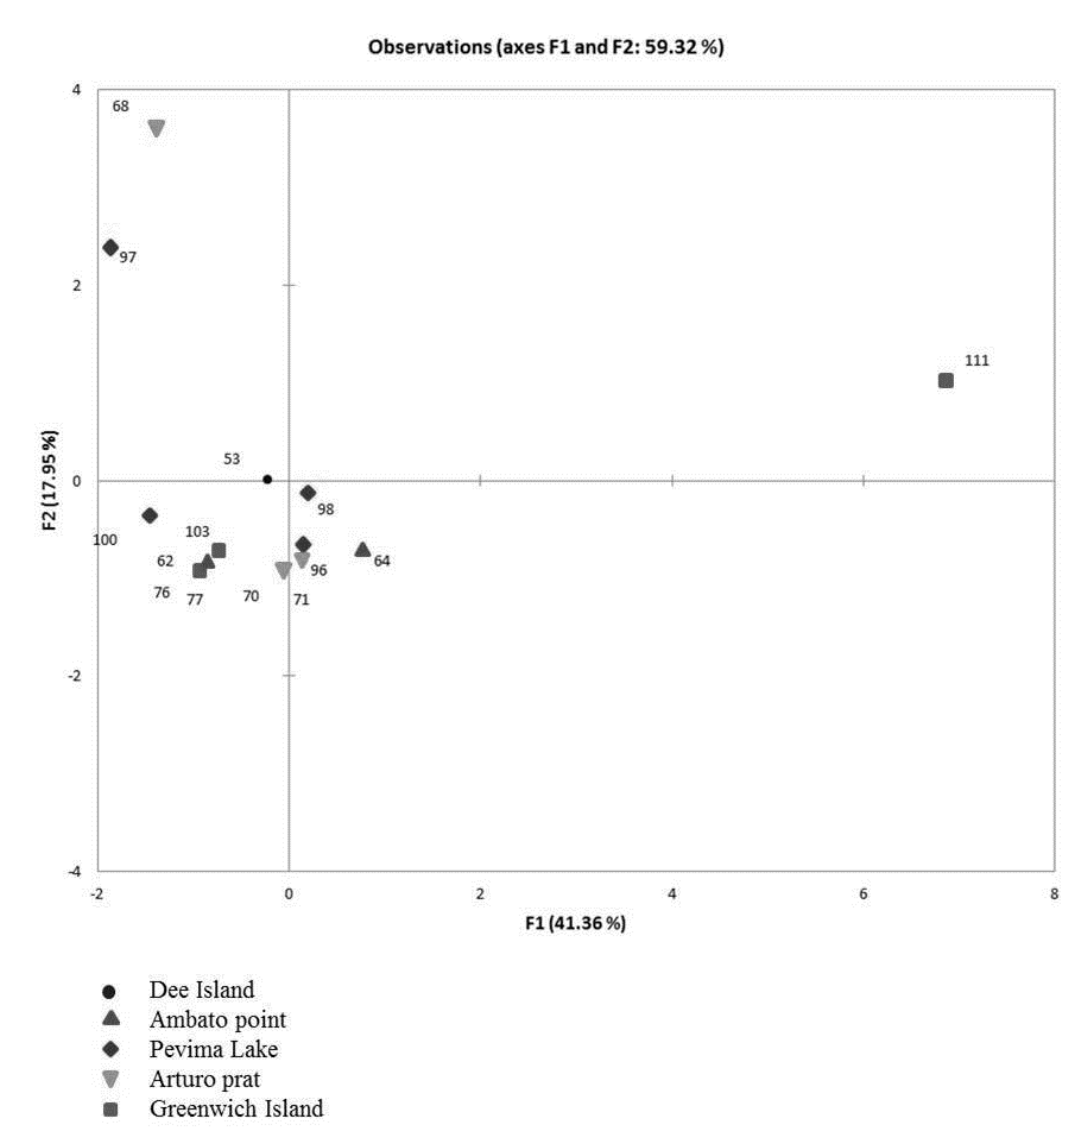
Figure 4: Ordination biplot generated by principal component analysis (PCA) of actinobacterial communities at genus